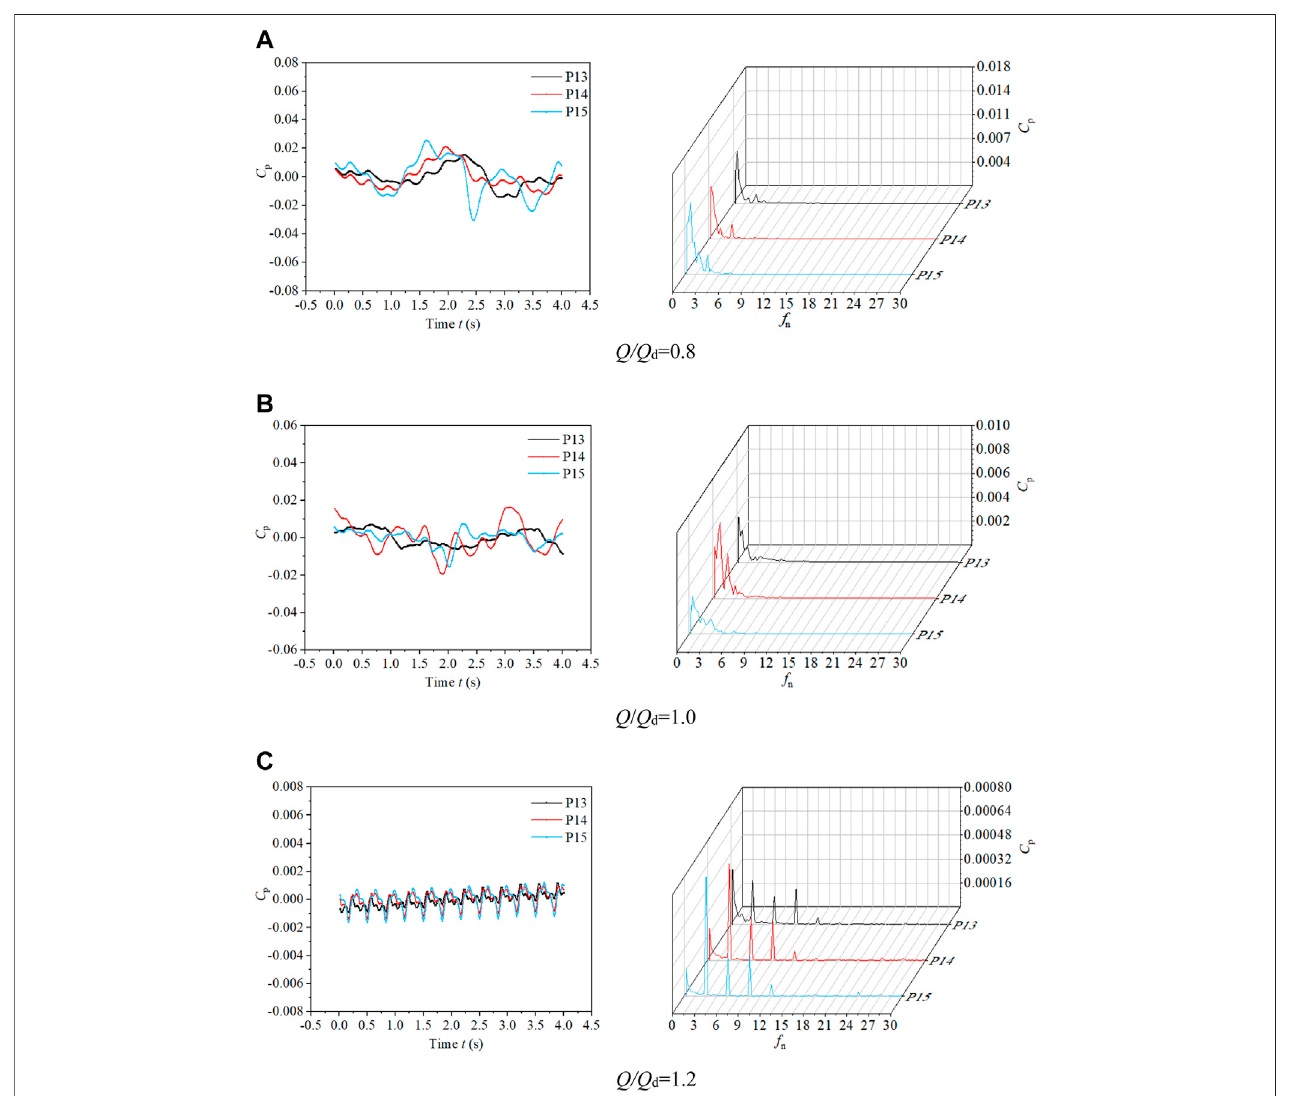
FIGURE 14 | Time domain chart and frequency domain chart of pressure pulsation on the guide vane outlet at monitoring points P13-P15 under different conditions. (A)